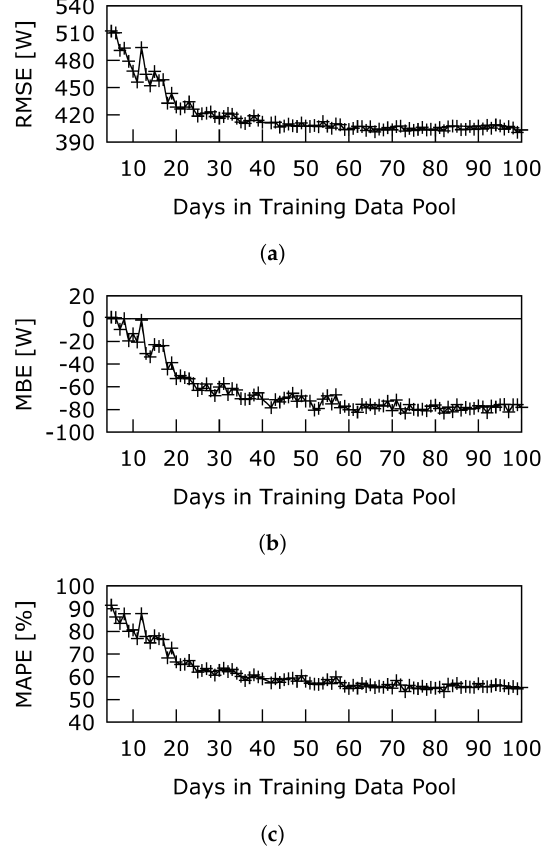
Figure 5. Error characteristics RMSE ( a ), MBE ( b )and MAPE ( c ) for using different training data pool